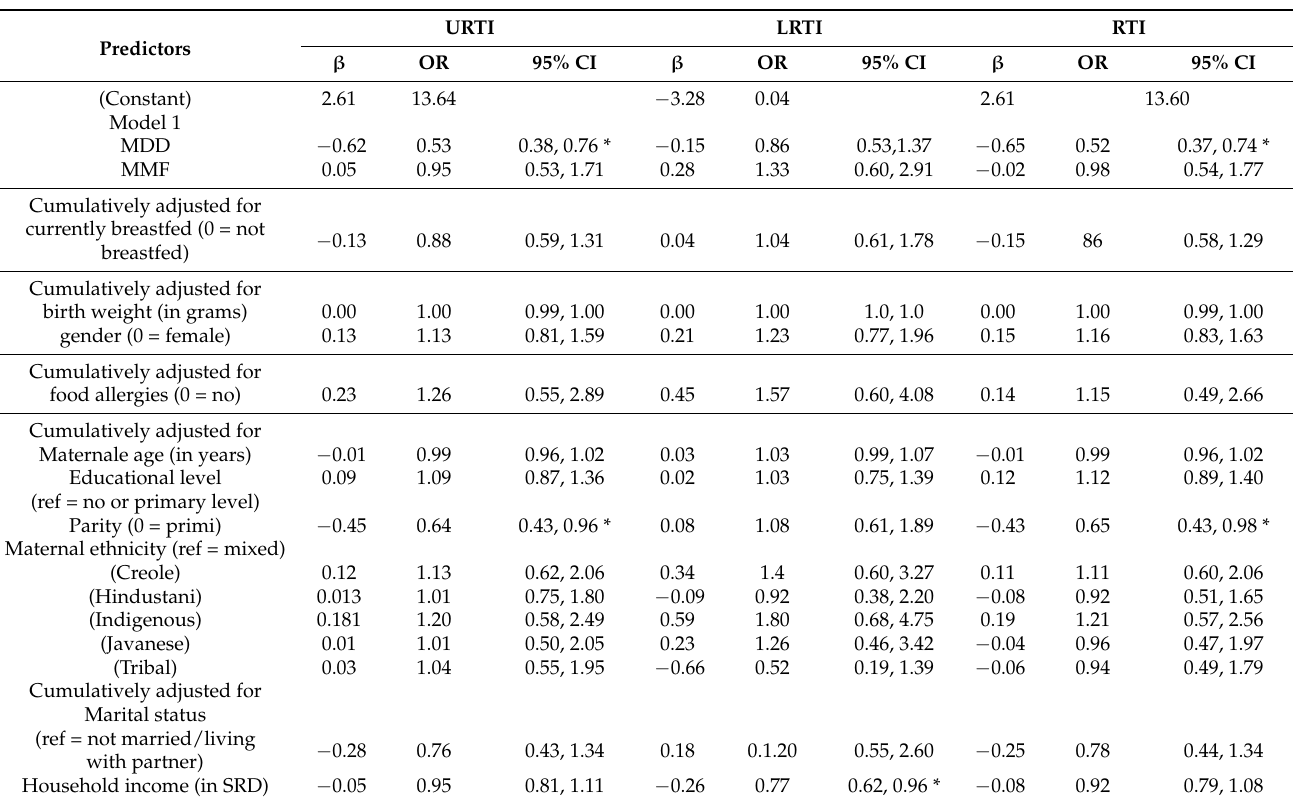
Table 2. Hierarchical logistic regression model 1: Association between the WHO Infant and Young Child feeding (IYCF) indicators minimum dietary diversity (MDD), minimum meal frequency (MMF), and respiratory tract infections